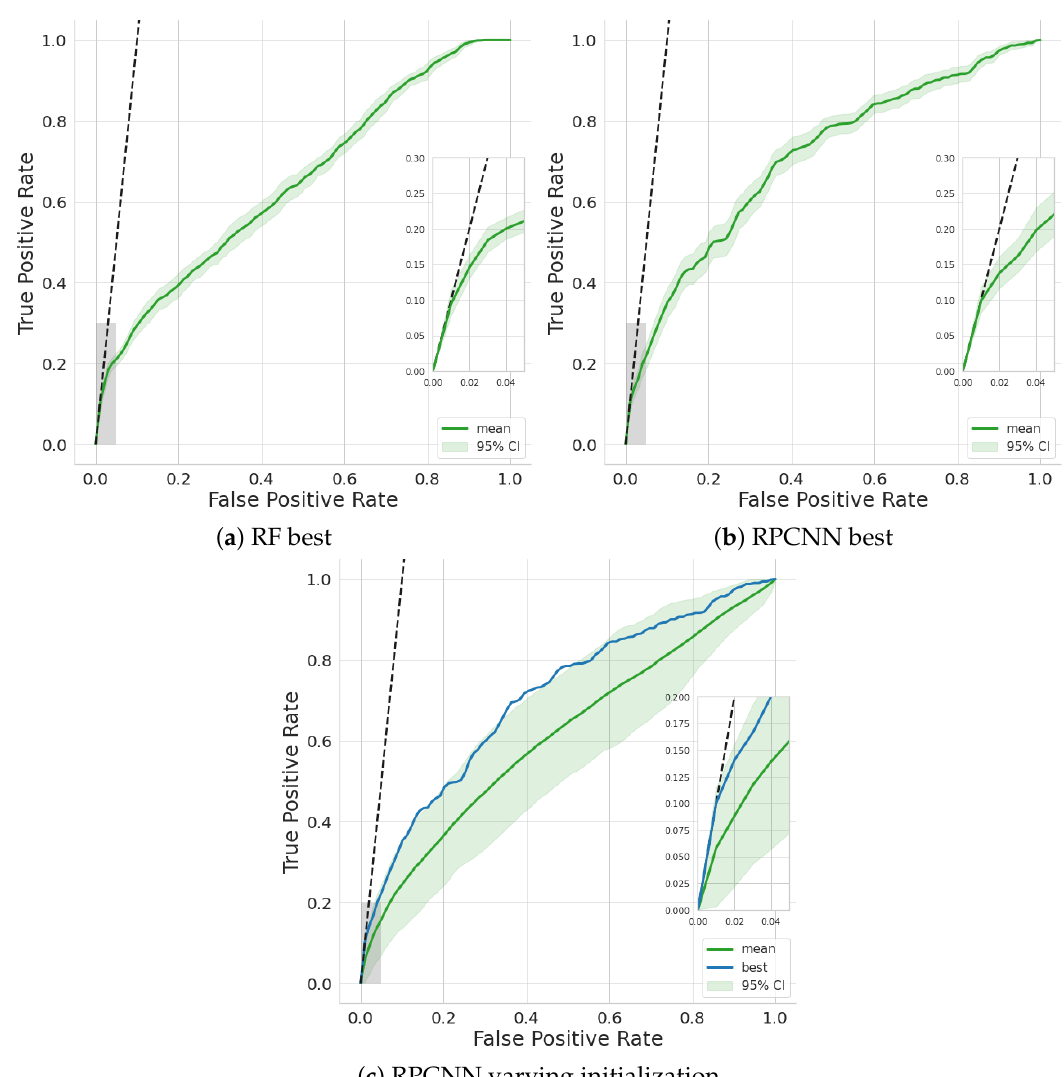
Figure 11. ROC curves of the best-performing models in terms of Beam time saved and AUC: ( a ) RF; ( b ) RPCNN. The mean and 95% confidence interval is calculated from re-sampling of the validation sets. ( c ) Varying initialization of the same RPCNN model as in ( b ). The mean and 95% confidence interval are calculated from the validation results of 25 model